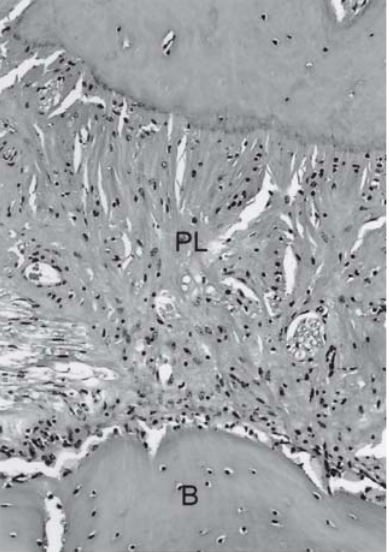
FIGURE 5 - Group II (Calcium hydroxide): normal periodontal ligament (PL) with densely vascularized connective tissue and presence of collagen fibers and cells. Absent inflammatory infiltrate and normal alveolar bone (B). (hematoxylin and eosin - X 80)